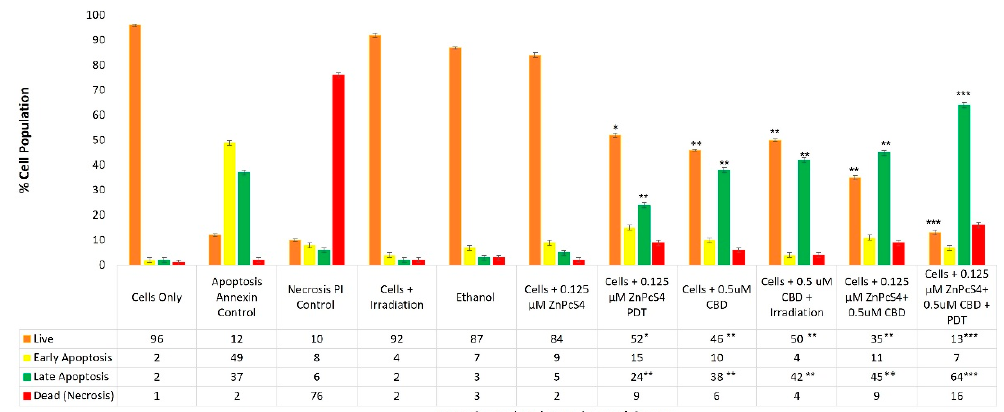
Figure 5. Percentage of different stages of cell death using the flow cytometry Annexin V-FITC/PI staining method on various HeLa control and experimental groups, within ZnPcS 4 PS and CBD PDT/irradiation combinative assays ( p < 0.05*, p < 0.01** or p < 0.001***).